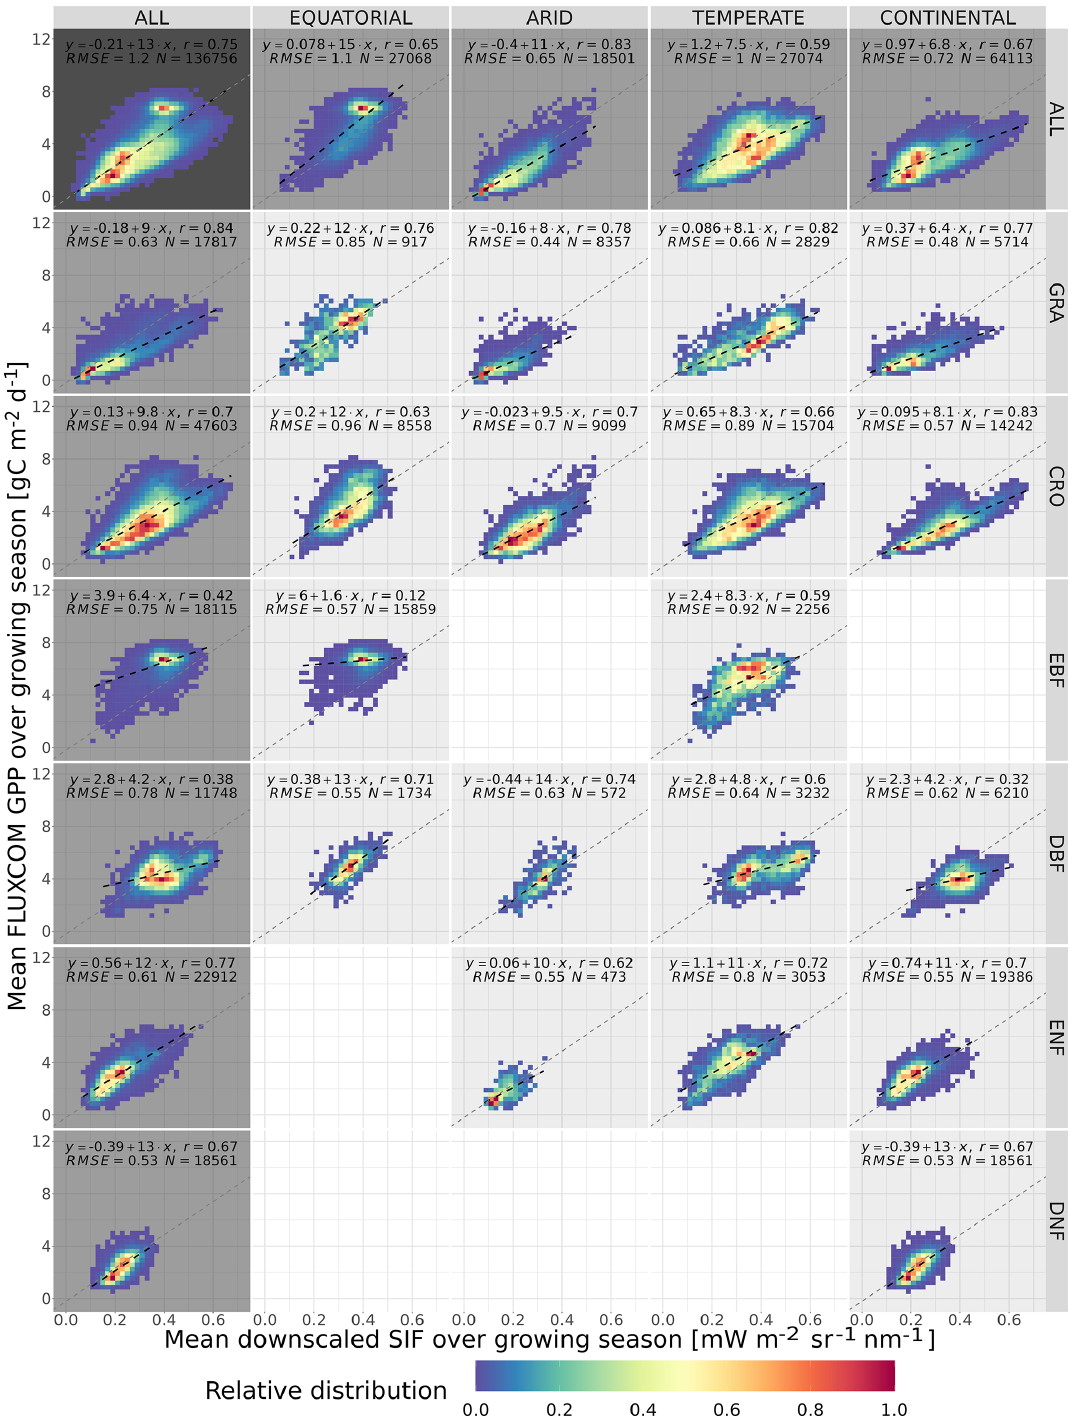
Figure 5. The spatial relationship between the mean growing-season downscaled SIF and FLUXCOM GPP, broken down into separate Köppen–Geiger climate zones and vegetation cover categories. The plot shows the frequency distribution of pixels into SIF DS –GPP FX bins, relative to the highest-frequency bin in that category. A dashed black line representing a linear model in each category is overlaid and compared to a dotted grey line representing a linear model produced without the breakdown into separate categories (i.e. ALL–ALL). The linear model equation, correlation coefficient r , root mean square error (RMSE) and number of pixels are